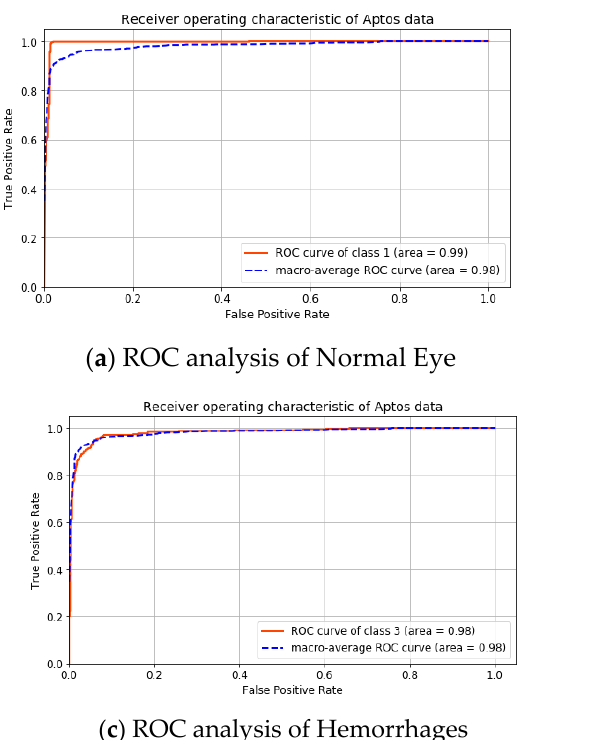
Figure 6. ROC analysis for APTOS dataset.